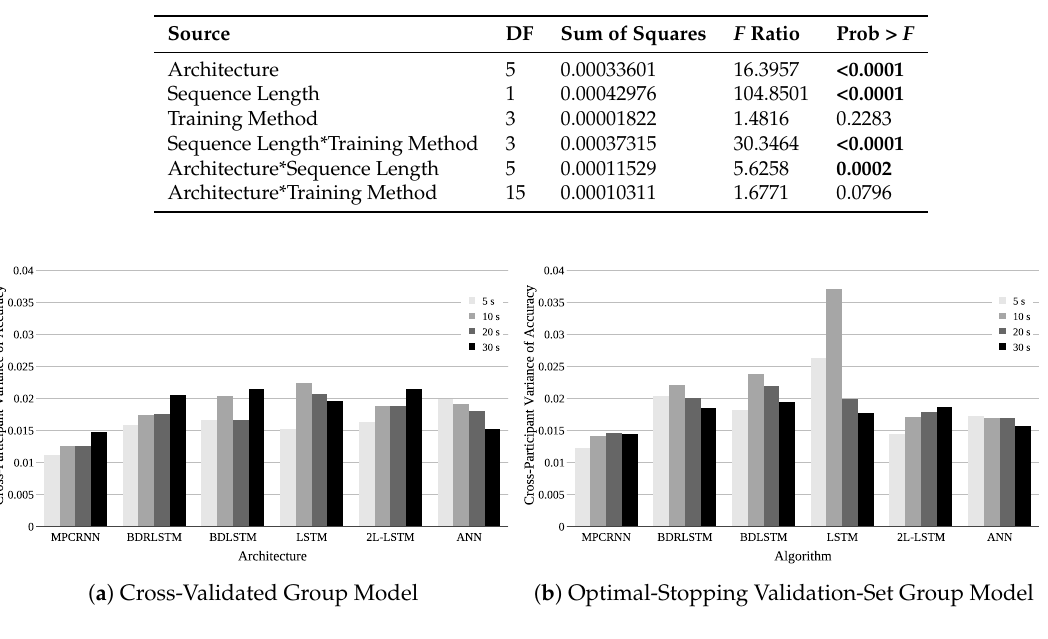
Table 5. Results of the 3-factor ANOVA evaluating the effects of architecture, sequence length, training method, and first-order interactions on cross-participant variance of classification accuracy. Significant results are displayed in bold.